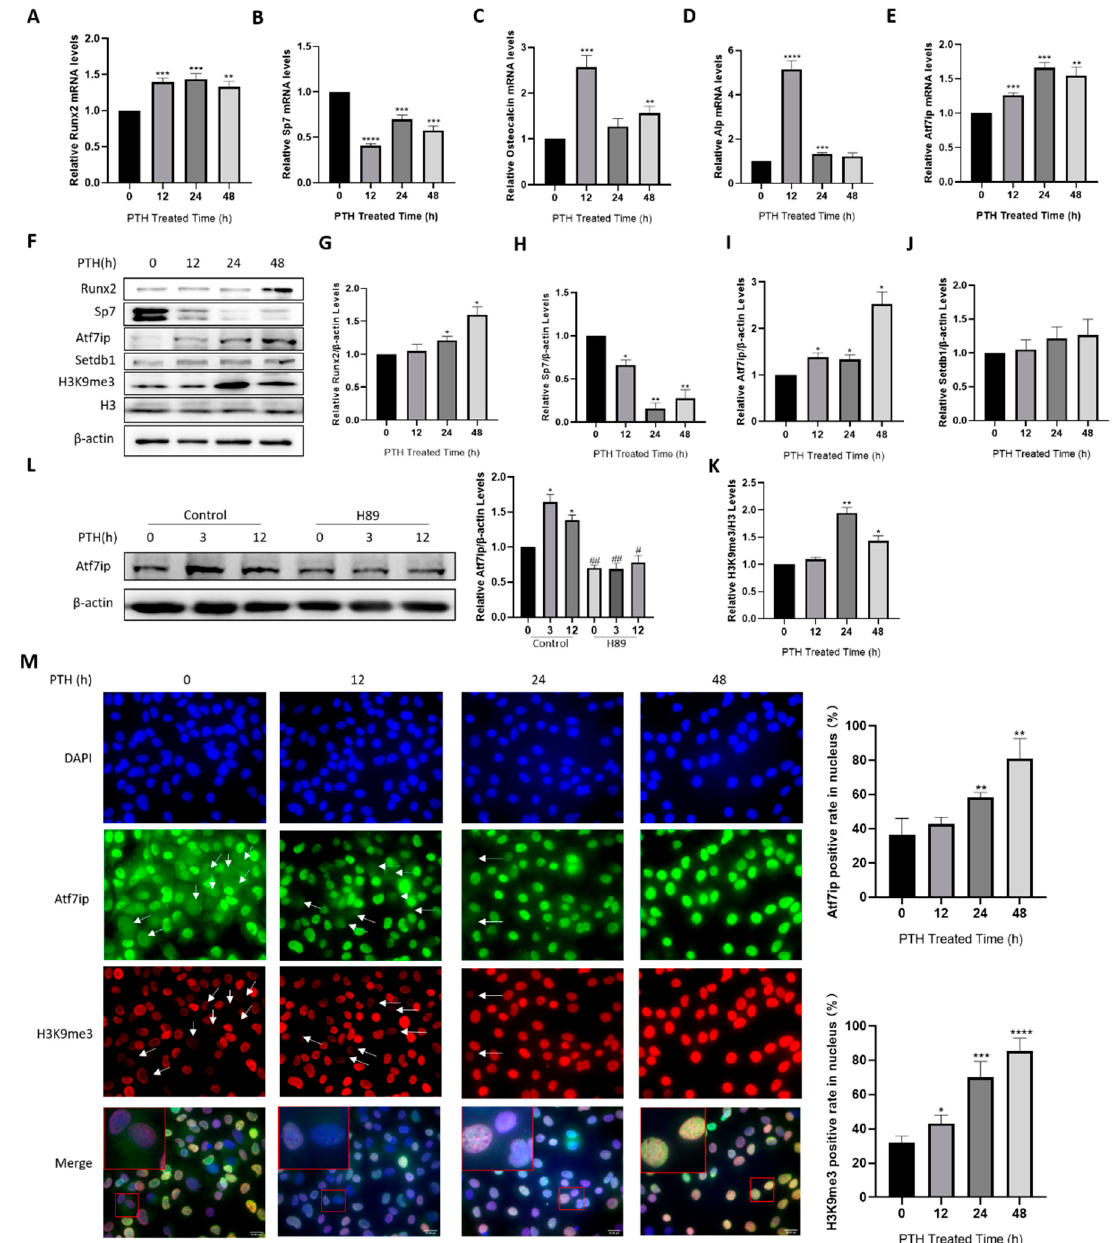
Figure 1. PTH induces Atf7ip expression in osteoblasts. MC3T3-E1 cells were treated with 500 ng/mL PTH for the indicated time. ( A – E ) The expressions of Runx2, Sp7, Osteocalcin, Alp, and Atf7ip were examined by real-time PCR, n = 3. ( F – K ) The protein expressions of Runx2, Sp7, Atf7ip, Setdb1, H3K9me3, and H3 were analyzed by Western blot, n = 3. ( L ) MC3T3-E1 cells were pretreated with 10 µ M of H89 for 12 h and cultured for 12 h in medium with 500 ng/mL PTH. Atf7ip expression was examined by Western blot. β -actin was used as the loading control. Representative images from independent experiments are shown. The densitometric results were measured with ImageJ (the same below), n = 3. ( M ) MC3T3-E1 cells were treated with 500 ng/mL PTH for the indicated time. The subcellular localization of Atf7ip and H3K9me3 was determined by immunofluorescence. The arrows indicate the cells without nucleus localization of Atf7ip and H3K9me3, and the cells with nuclear localization of Atf7ip or H3K9me3 were calculated with Image J, n = 4. Scale bar, 20 µ m. Selected sections magnified 10-fold. Data are represented as mean ± SD, * p < 0.05, ** p < 0.01, *** p < 0.001, **** p < 0.0001, treatments vs. no treatment. # p < 0.05, ## p < 0.01, H89 vs. control, examined by one-way